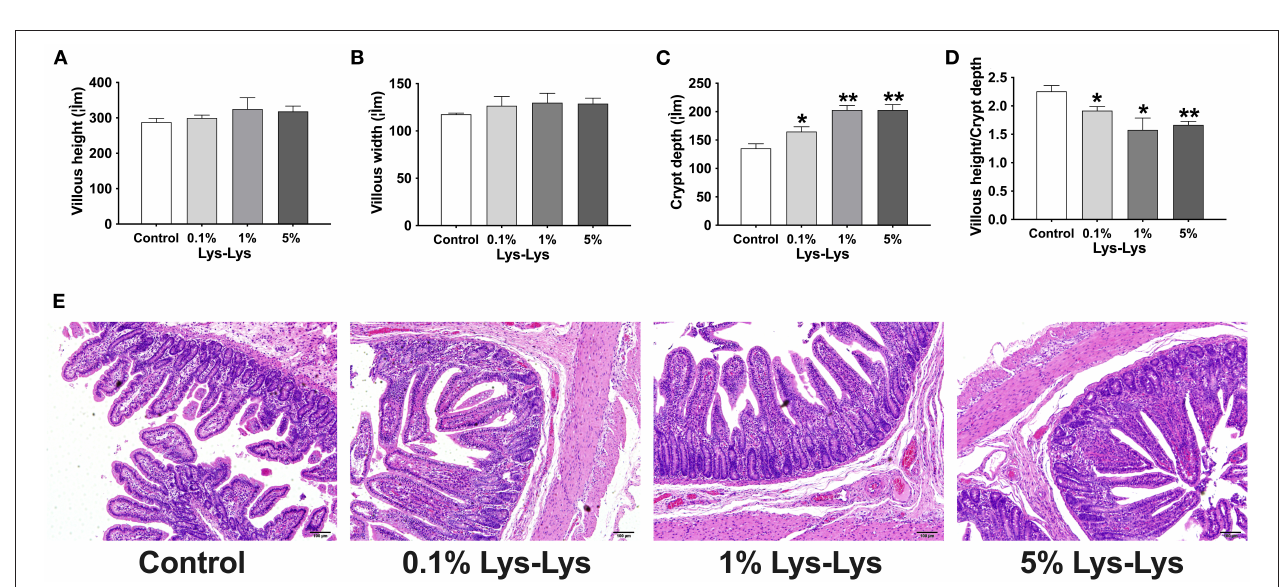
FIGURE 1 | Effect of the Lys-Lys dipeptide on growth performance in piglets. (A) Weight gain and (B–E) organ relative weight were calculated according to the formula organ/body weight. Data were expressed as the mean ± SEM ( n = 7).